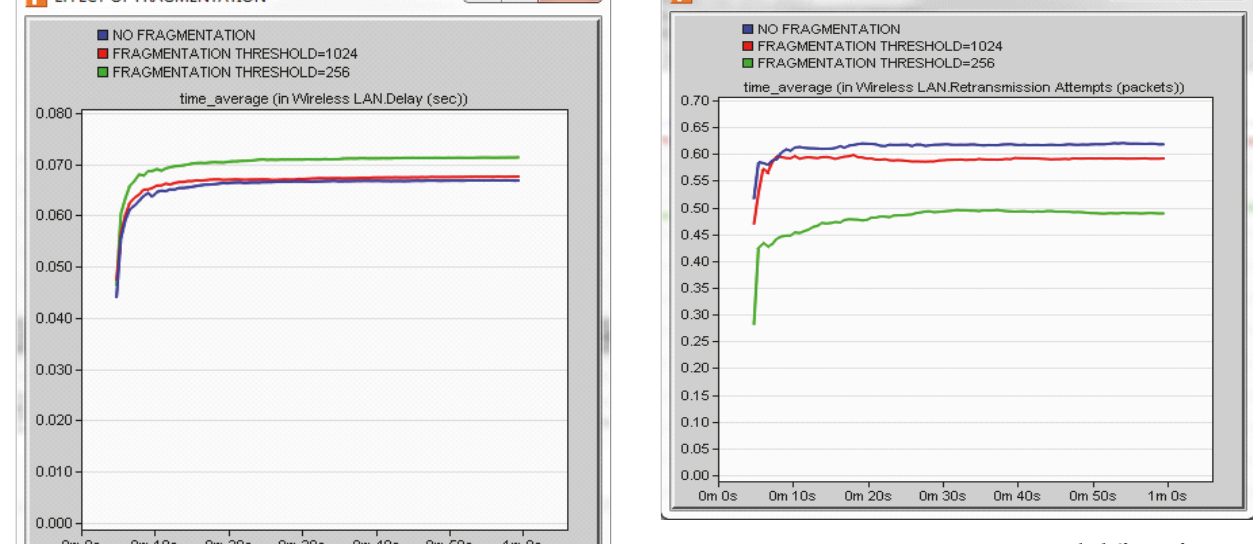
Figure 16: WLAN retransmission attempts with different fragmen- tation thresholds and without fragmentation.